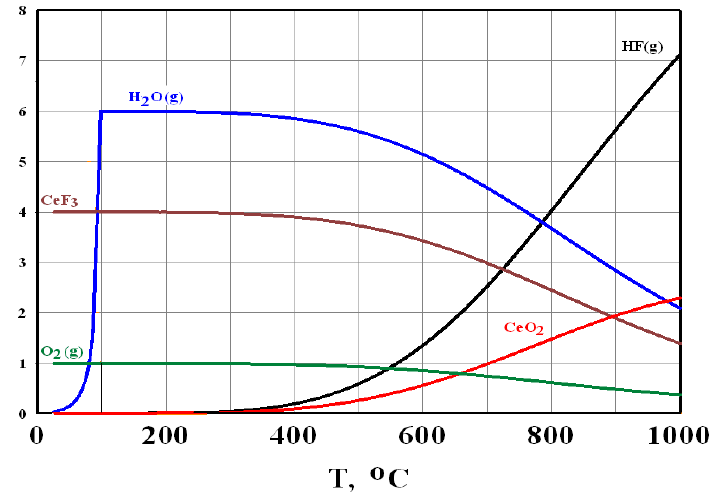
Figure 6. Equilibrium amounts of reacting components and products of the reaction (12) for various temperatures according to the results of calculations using the HSC Chemistry 8 software package.